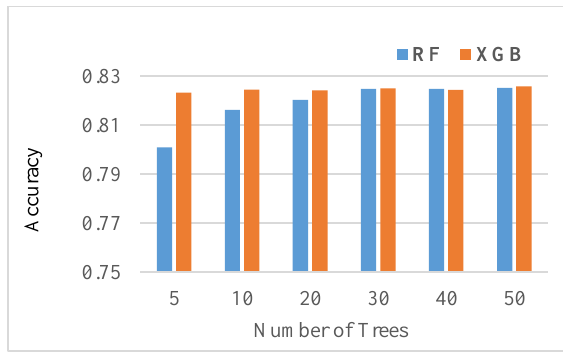
Figure 2 . Performance of the Random Forest and Extreme Gradient Boosting for different numbers of